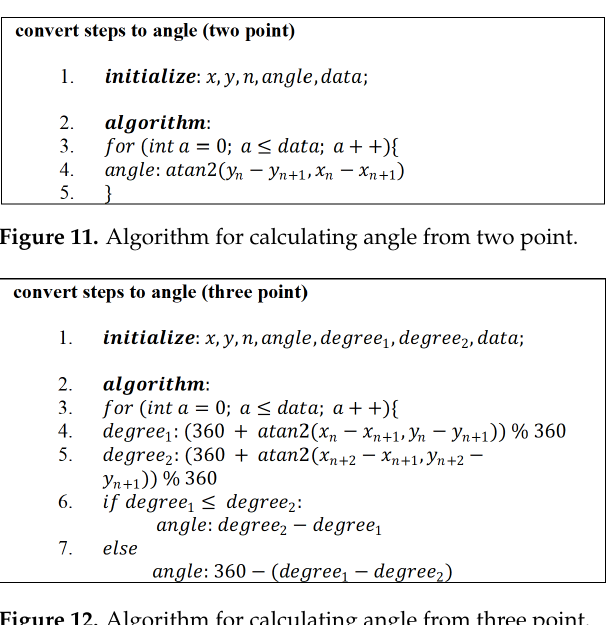
Figure 12. Algorithm for calculating angle from three point.